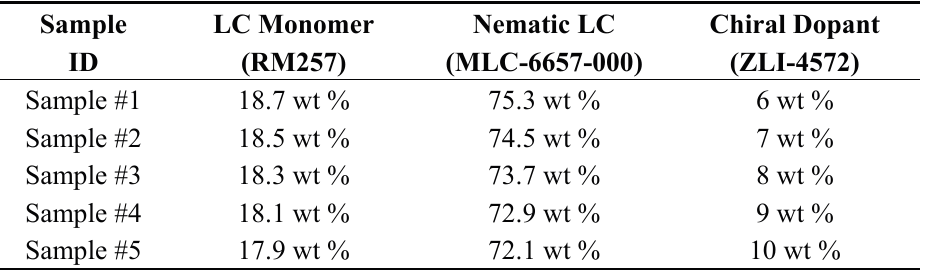
Table 1. Compositions of the samples used in this study.